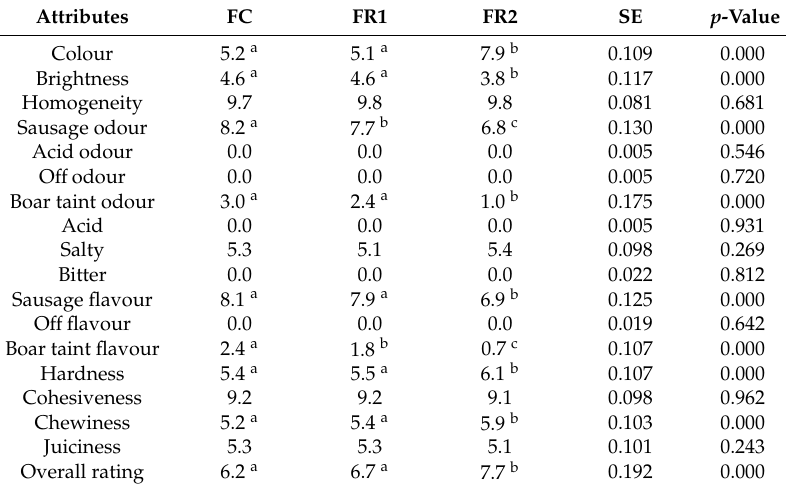
Table 5. Sensory analyses LSM +/ - SE of Frankfurt sausages.